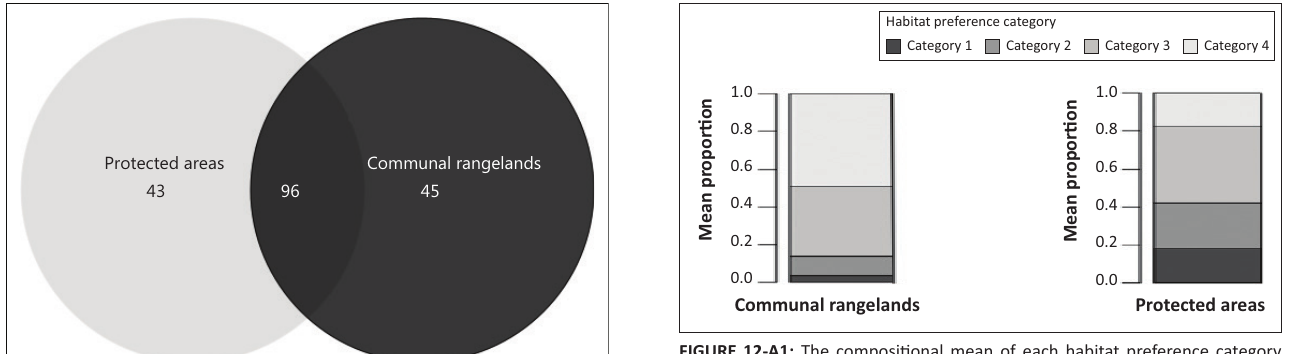
FIGURE 12-A1: The compositional mean of each habitat preference category between the two land-uses (protected areas versus communal rangelands). Category 1 = birds that associate with open grassy areas, category 2 = birds that associate with open grassy and closed canopy wooded areas, but have a greater affinity for open grassy areas, category 3 = birds that associate with open grassy areas and closed canopy wooded areas, but have a greater affinity for closed canopy wooded areas and category 4 = birds that associate with closed canopy wooded